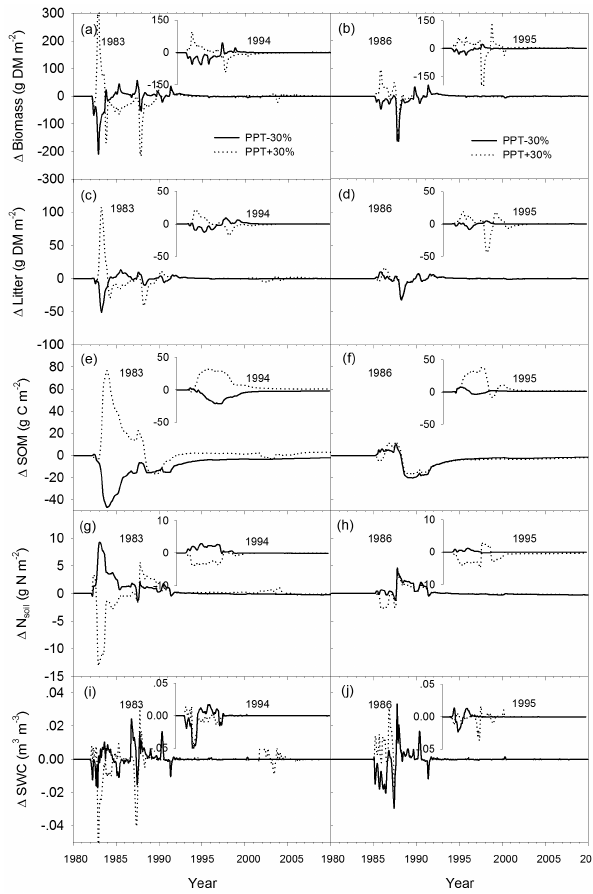
Figure 7. Interannual precipitation legacy effects on resource pool dynamics. Left panels show the legacy effects on pool dynamics in 2 representative wet years, while right panels for 2 representative dry years. Legacy effects on pool size (e.g., (cid:49) Biomass) are quantified as the difference between the current-year pool size with previous- year PPT change and that without previous-year PPT change. Solid lines represent a 30% decrease, while dashed lines represent a 30% increase in the previous-year precipitation (PPT). SOM represents soil organic matter, N soil soil mineral nitrogen, and SWC soil water